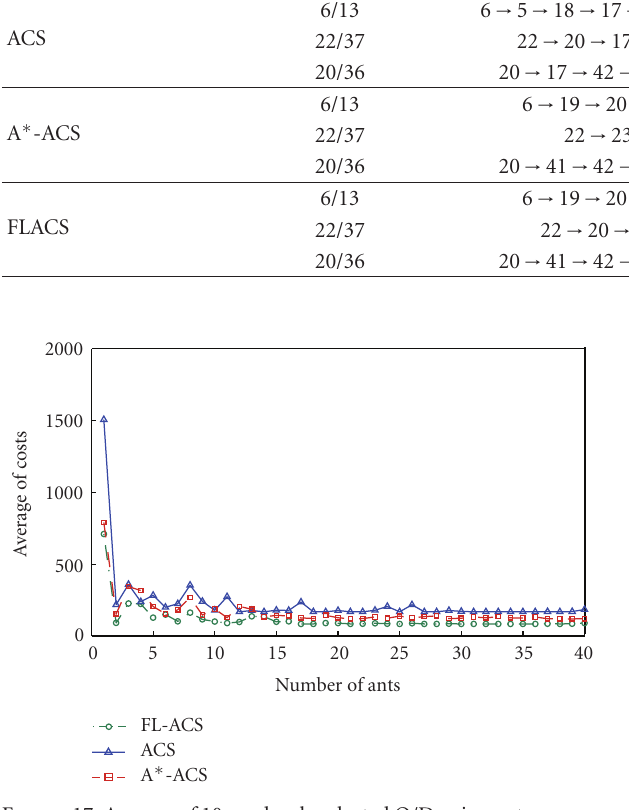
Figure 17: Average of 10 randomly selected O/D pairs cost averages for di ff erent number of ants. A comparison between performance of ACS, A ∗ -ACS, and FLACS algorithms is